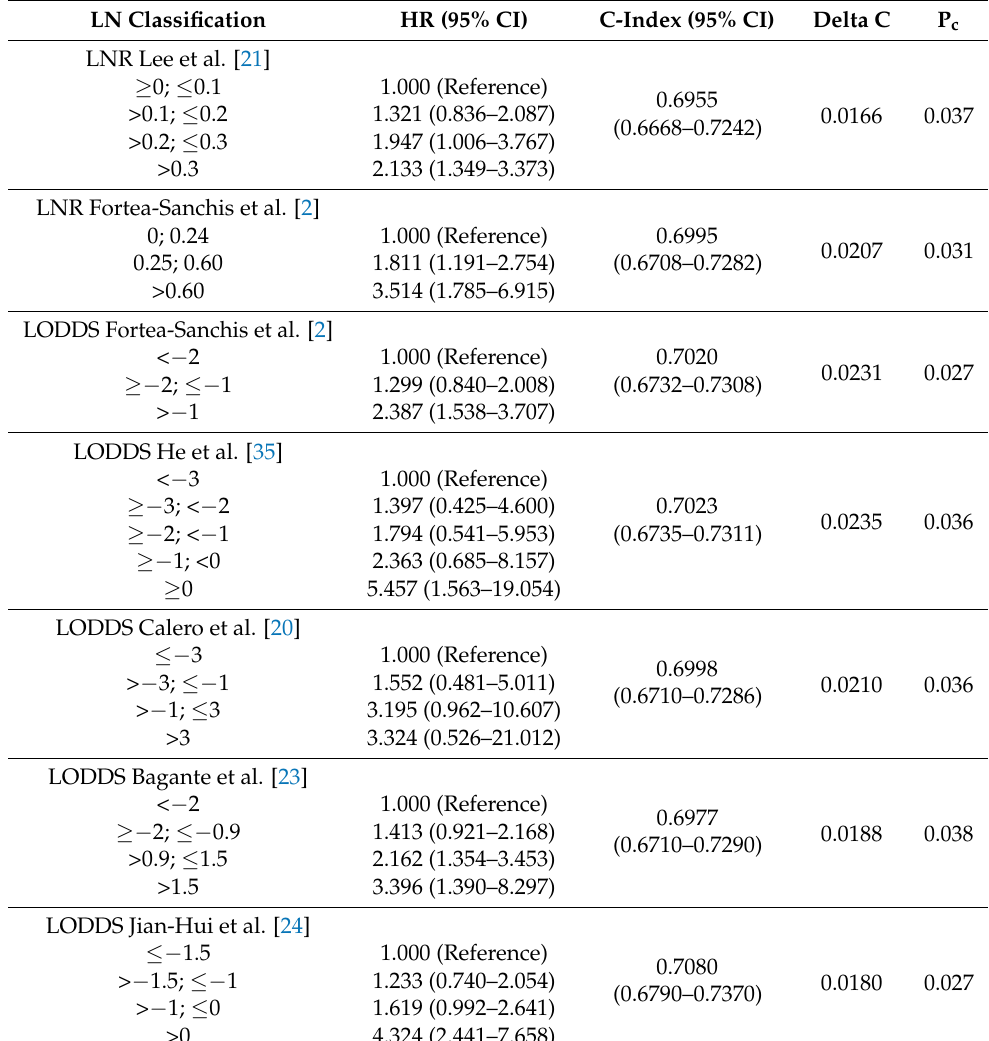
Table 3. Summary of the LN classification systems that demonstrate better prognostic discrimination than the N category in UICC III CRC